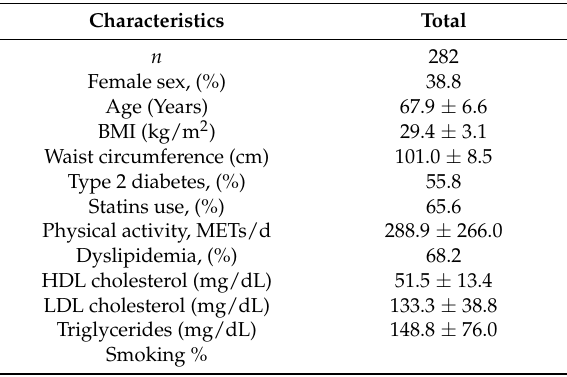
Table 1. Baseline characteristics of the study